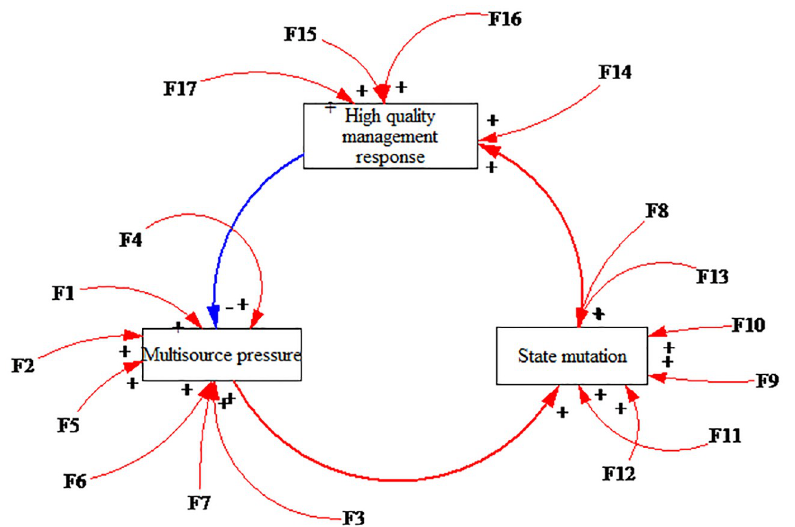
Fig 2. The operating mechanism of highly aggregated tourist crowds in a safe